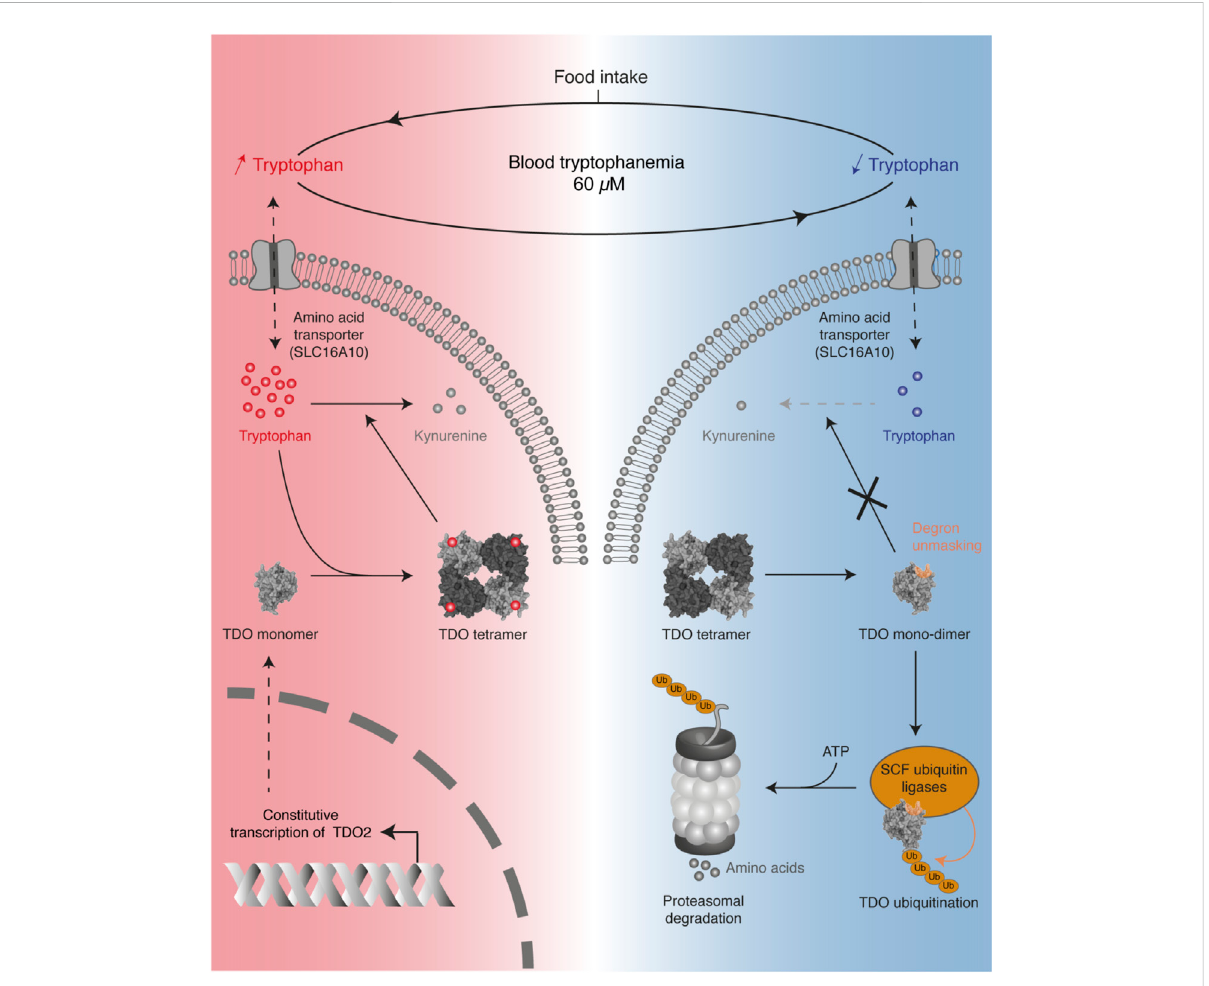
FIGURE 6 Overview of the mechanism regulating TDO stability in the liver to control blood tryptophanemia. Protein intake increases the blood level of tryptophan, which accumulates inhepatocytes (redcolor). High tryptophan levels stabilize thetetrameric conformation of TDOthrough thebinding oftryptophaninfourexosites,therebystimulatingtryptophancatabolism.Whentryptophanbecomesscarce(bluecolor),theabsenceoftryptophan bindingtheexositesdestabilizesthetetramericstructureofTDOininactivemonomersanddimers.Absenceoftryptophanunmasksadegronin the exosites, which triggers TDO ubiquitination by SKP1-CUL1-F-box complexes. This fi nally induces TDO degradation by the proteasome, thereby stopping tryptophan